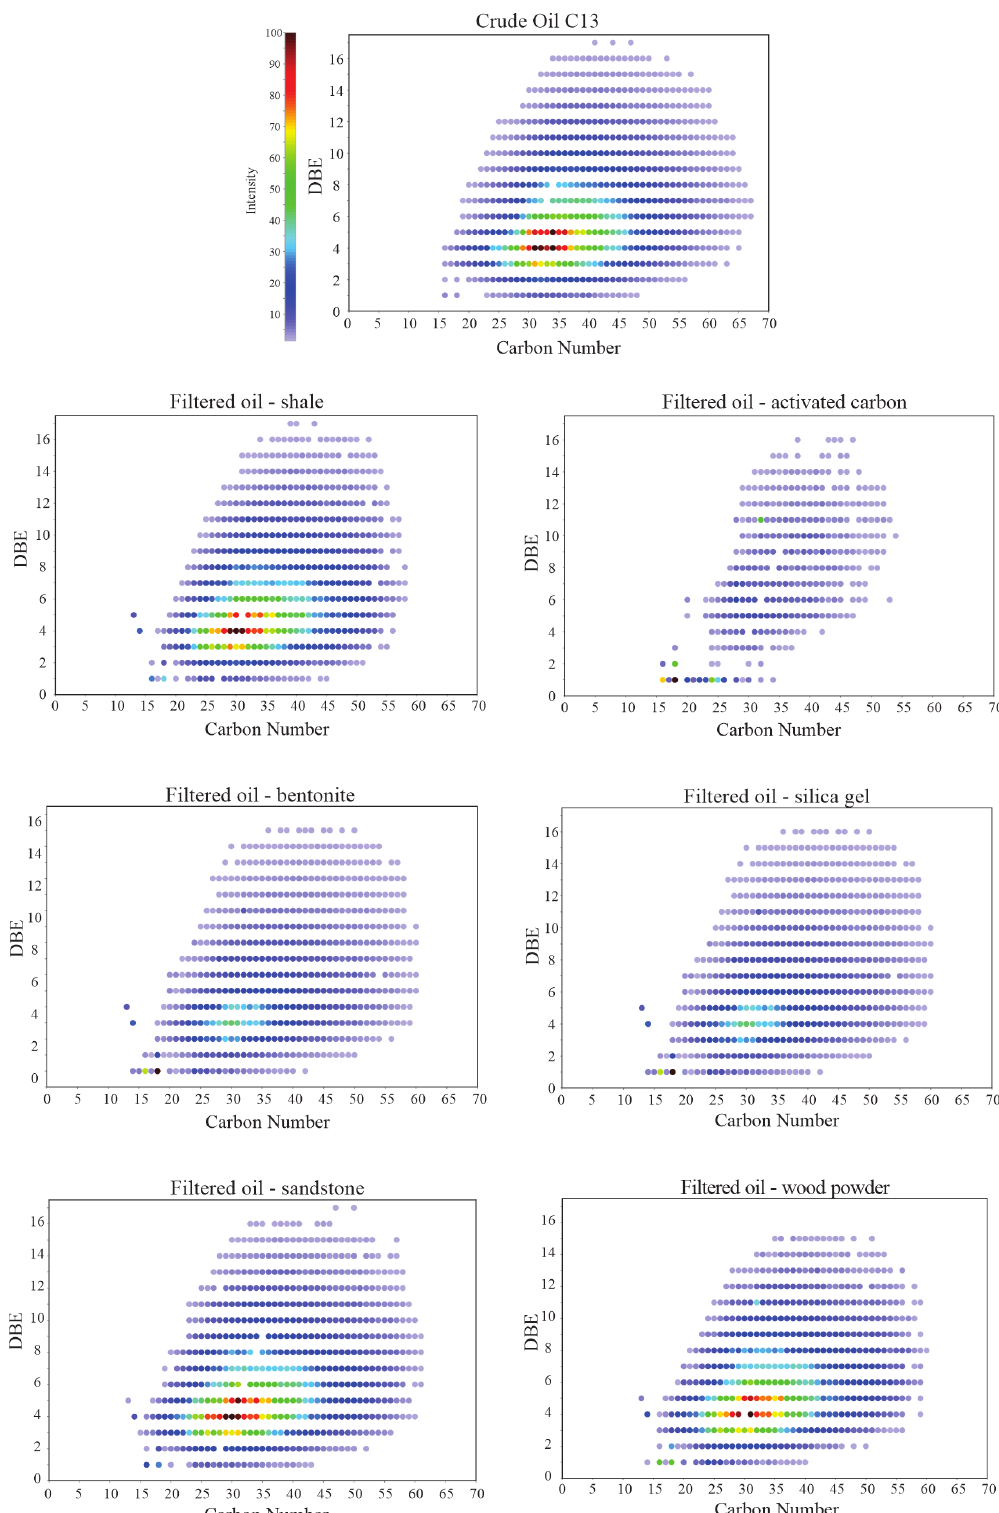
Figure 5. Isoabundance contoured plots of DBE versus carbon number for the O